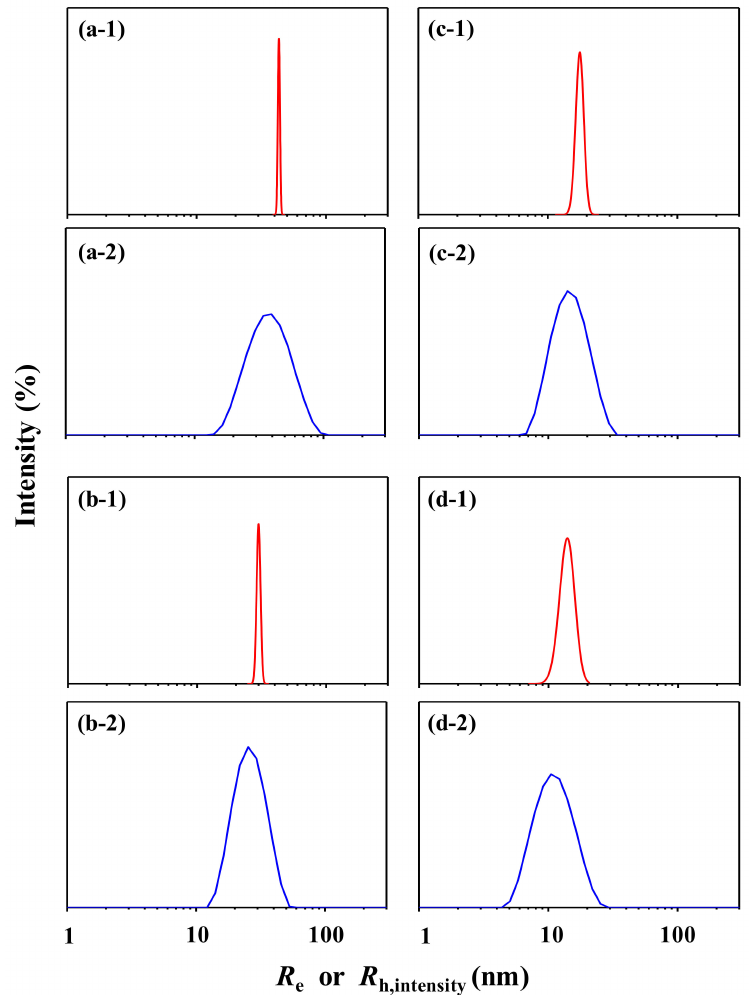
Figure 3. Radius distributions of PS particles determined by X-ray scattering and DLS analyses: ( a-1 ) PS-1 ( σ = 0.8 nm), from X-ray scattering; ( a-2 ) PS-1 ( σ = 14.7 nm), from DLS; ( b-1 ) PS-2 ( σ = 1.0 nm), from X-ray scattering; ( b-2 ) PS-2 ( σ = 7.4 nm), from DLS; ( c-1 ) PS-3 ( σ = 1.3 nm), from X-ray scattering; ( c-2 ) PS-3 ( σ = 4.7 nm), from DLS; ( d-1 ) PS-4 ( σ = 1.8 nm), from X-ray scattering; ( d-2 ) PS-4 ( σ = 3.9 nm), from DLS. Here, it is noted that the radius distributions based on the scattering intensities in ( a-1 ), ( b-1 ), ( c-1 ), and ( d-1 ) were obtained from the radius distribution based on the number populations in Figure 1i, Figure 4i, Figure 5i, and Figure 6i using a relation of the scattering intensity and the volume of the particles in population; such relation is given in Supporting Information. The X-ray scattering analyses were conducted for the scattering data corrected with the supernatant